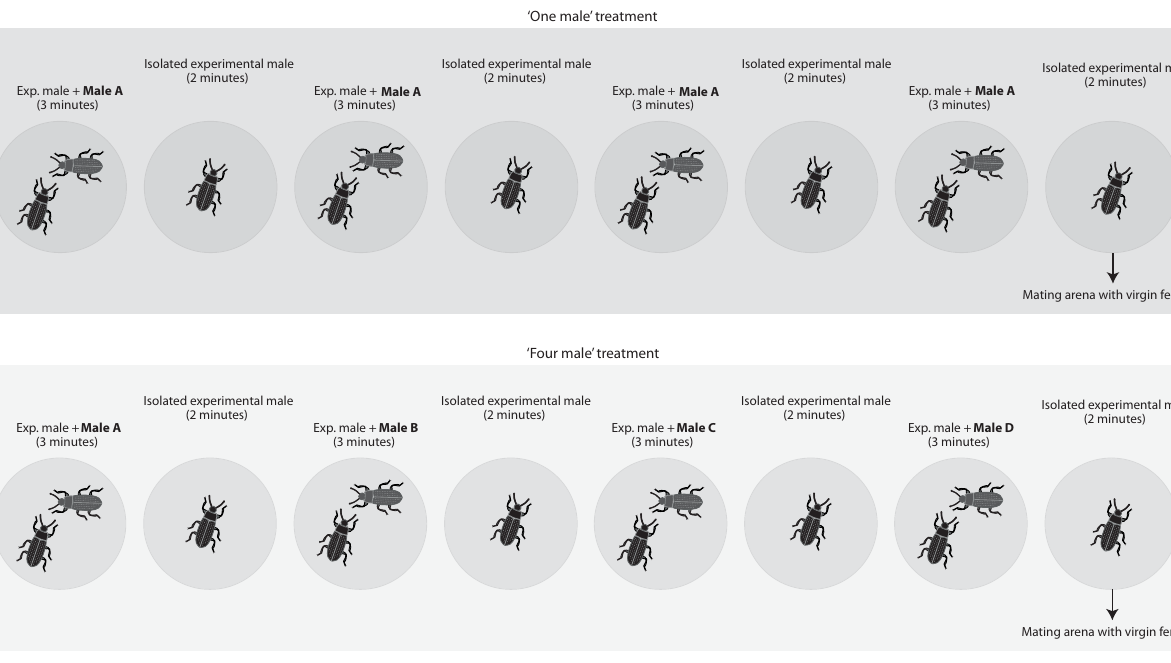
introducing the experimental male in a mating arena with a virgin female. Each male was subject to one of four different treatments. In the “one male” treatment, the male introduced during the four 3min periods was always the same. In the “two males” treatment, we used two different males that were alternated. In the “three males” treatment, we introduced three different males and repeated one of the first two males in the last presentation. Finally, in the “four male” treatment each introduced male was